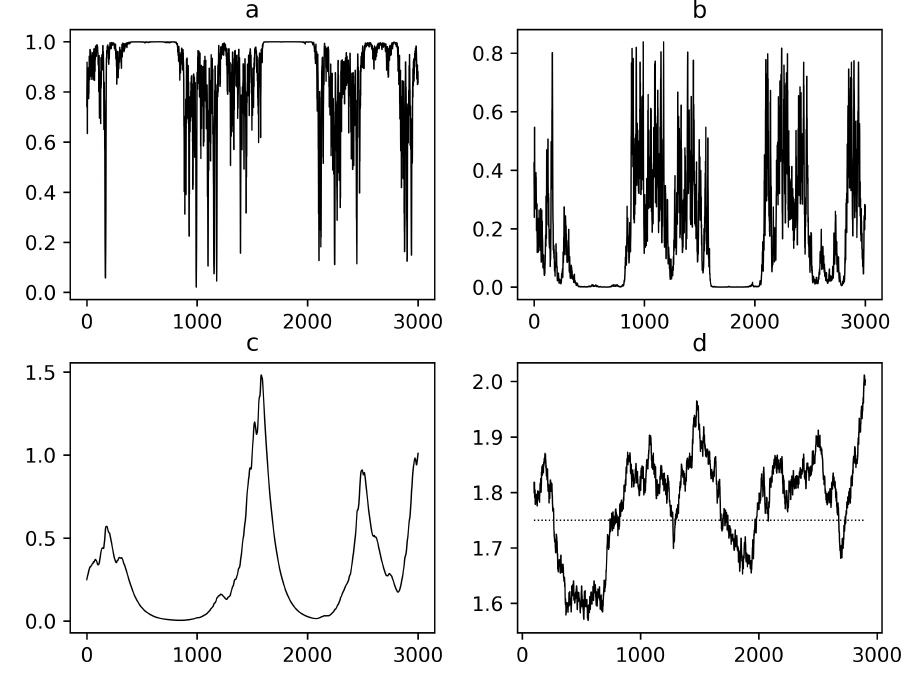
Figure 1. Case α = 3.5 for stochastic a 1 . Time series of x (Panel a ), y (Panel b ), z (Panel c ) and of the running mean of ˜ a 1 computed on a window with width τ = 200—the dotted line is the mean value of ˜ a 1 (Panel d